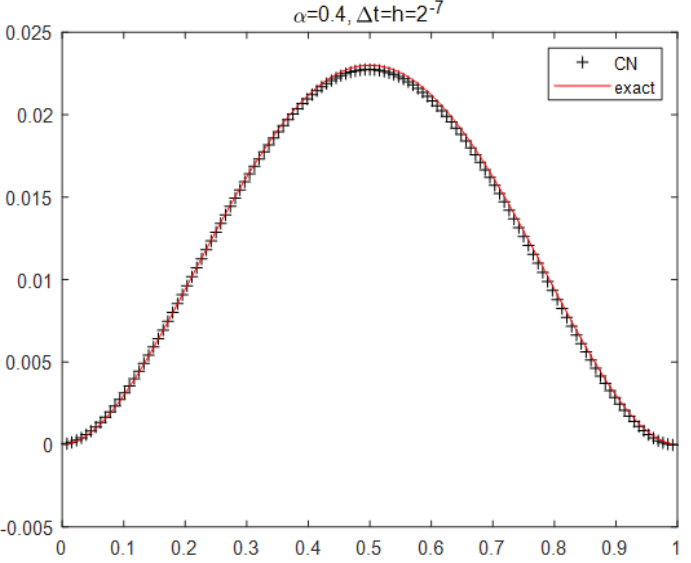
Figure 2. The numerical solution for the Crank-Nicolson scheme and exact solution for Example 1 with α = 0.4, ∆ t = h = 2 − 7 at time T =